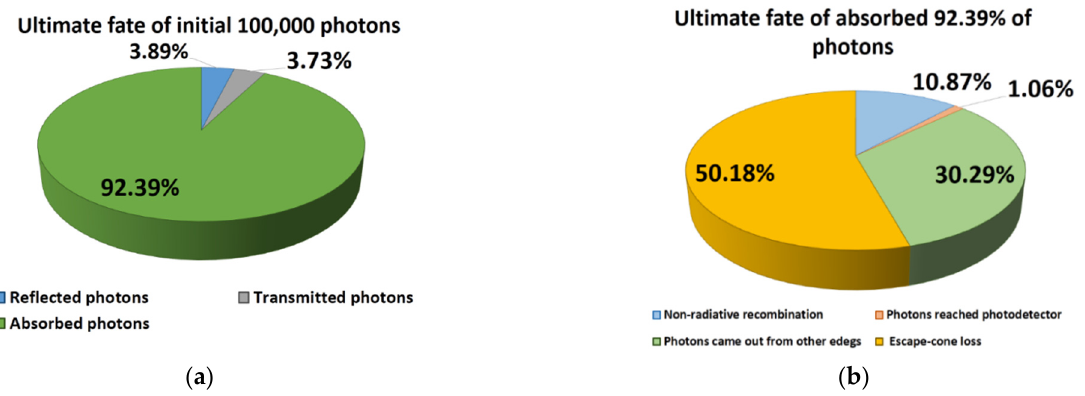
Figure 7. The fate of photons after simulation. ( a ) Contribution of reflected, transmitted, and absorbed photons. ( b ) Contribution of losses (non-radiative recombination, escape-cone loss) and beneficial photons (reached the photodetector and other edges).